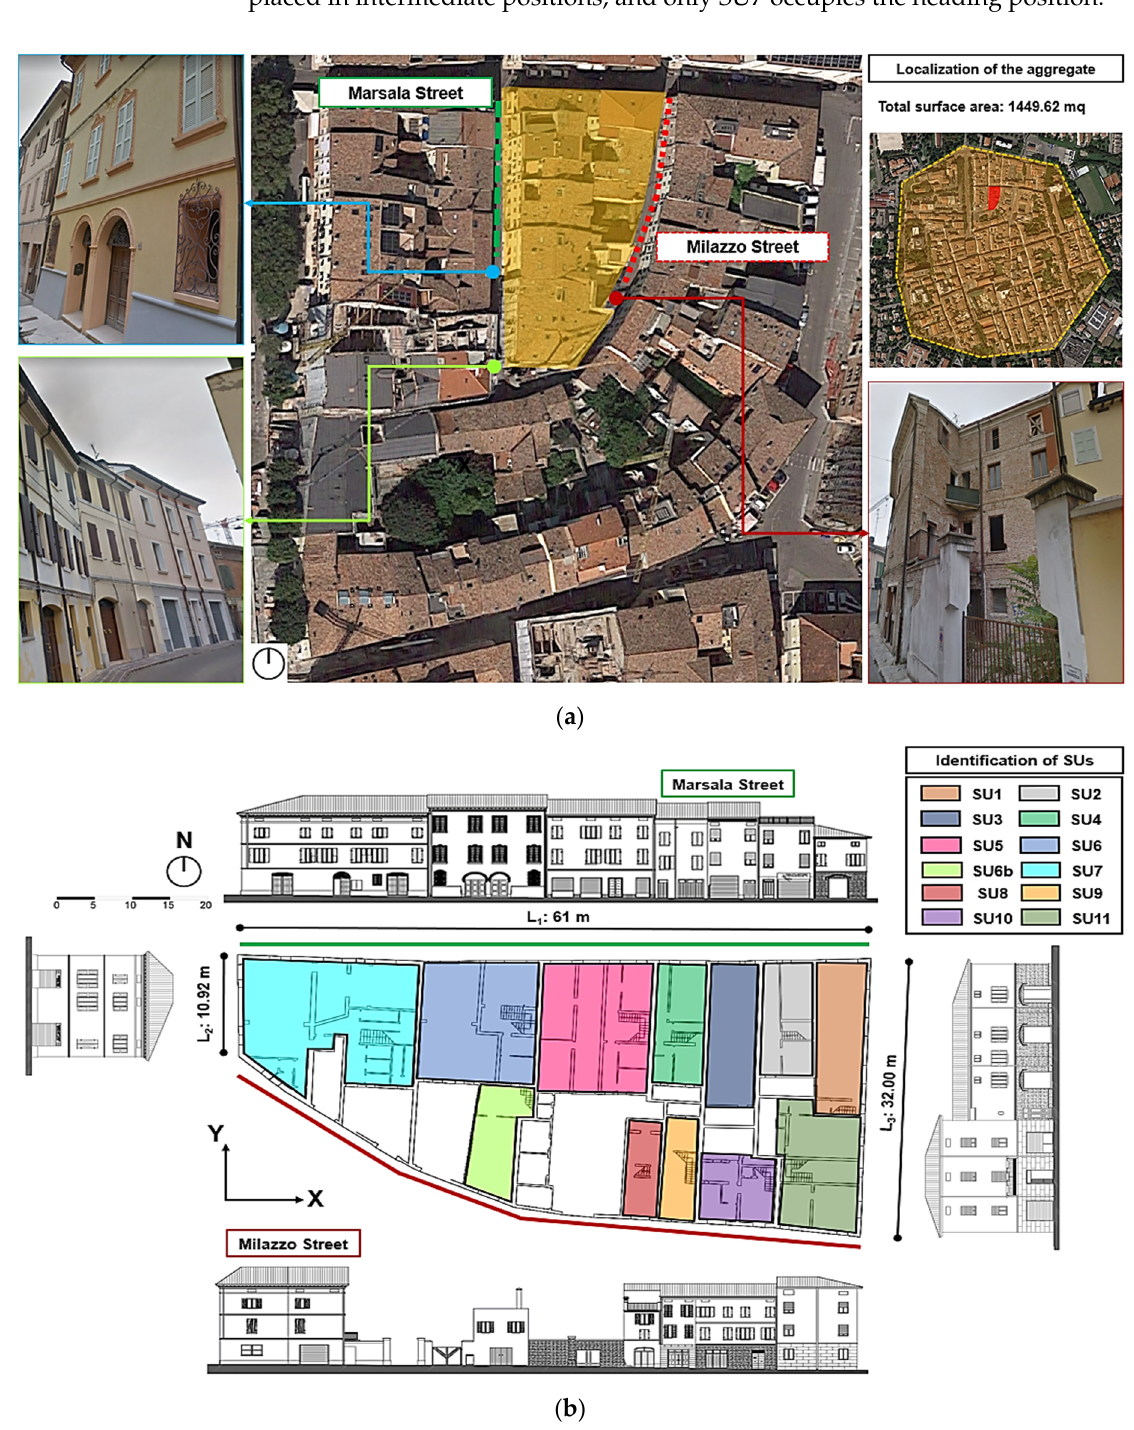
Figure 3. Localization of the case study aggregate ( a ) and identification of clustered structural units (SUs) ( b ). On average, the number of floors of the various SUs varies from 2 to 4 above ground, with an average inter-floor height of 2.80 m